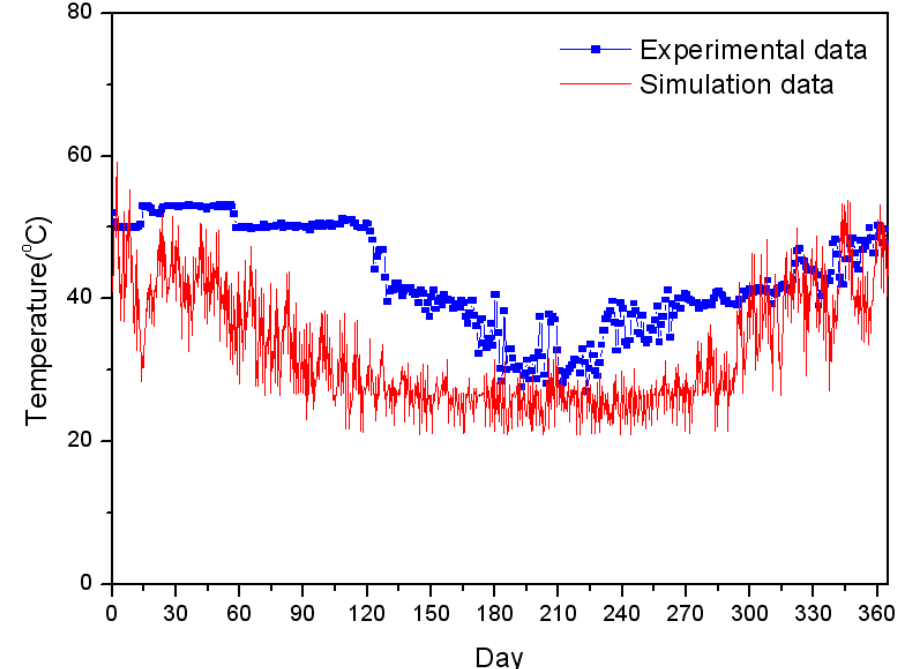
Figure 15. Comparison of experimental and optimized simulation data of supply water temperatures at group energy apartment building during a day for a